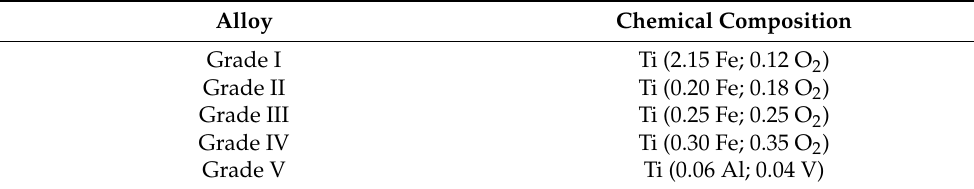
Table 1. Classification of titanium.